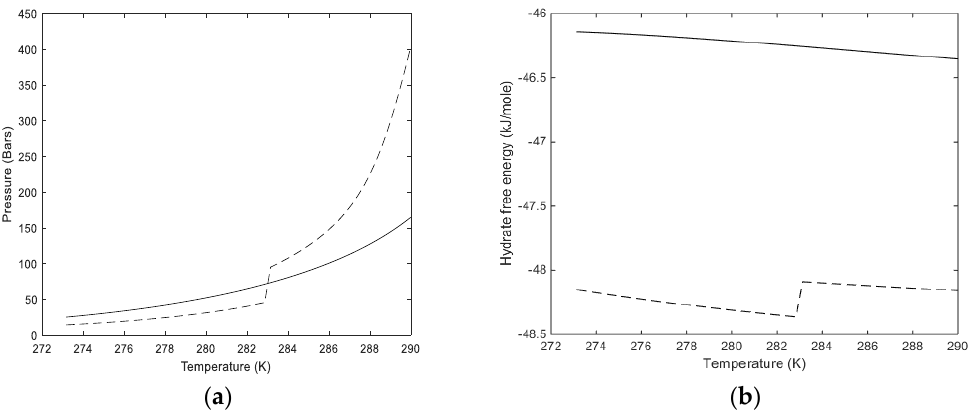
Figure 10. ( a ) Pressure temperature equilibrium curves for CH 4 hydrate (solid) and CO 2 hydrate (dash). ( b ) Free energies for hydrates of CH 4 (solid) and CO 2 (dash) hydrates along their equilibrium conditions of temperature and pressure.